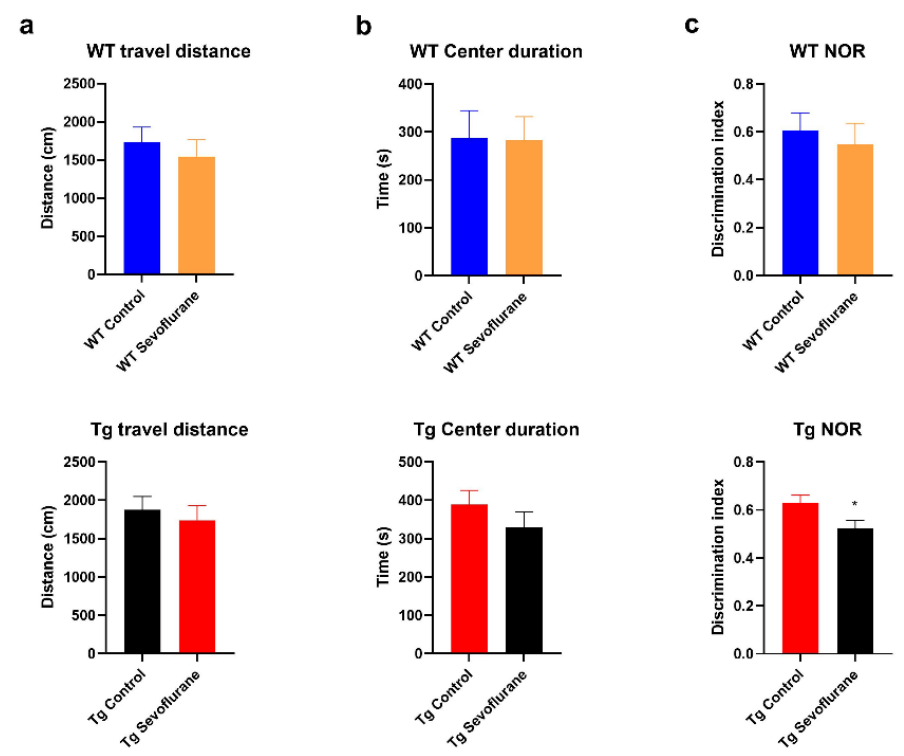
Figure 1. Sevoflurane induced cognitive deterioration in 3 × Tg mice but not in wild-type mice. Locomotor function, anxiety response, and cognitive function were examined using the open field test and the novel object recognition test in wild-type mice ( n = 6) and 3 × Tg mice ( n = 6), respectively. ( a , b ) No significant impact on locomotor function and anxiety was found in wild-type mice and 3 × Tg mice after sevoflurane exposure. ( c ) No significant cognitive change was observed in wild-type mice, while significant cognitive deterioration (decrease in discrimination index) was found in 3 × Tg mice after sevoflurane exposure. Data correspond to the mean ± SEM. * p < 0.05 in comparison to the control. Values were analyzed using the unpaired t -test.